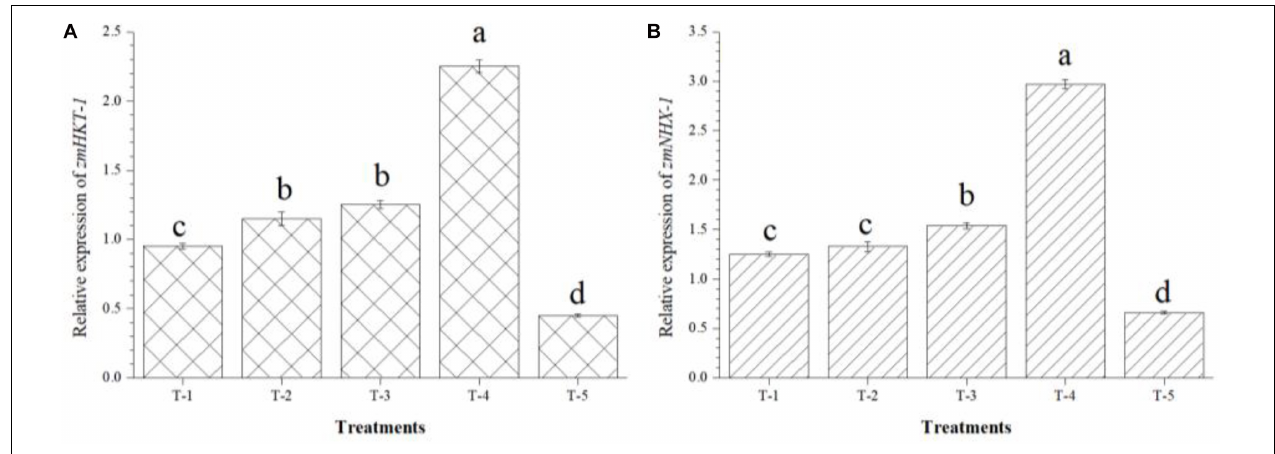
FIGURE 7 | Effects of seed bio-inoculation on expression profile of (A) zmHKT-1 and (B) zmNHX1 genes (fold change) in the maize roots grown in saline sodic soil at 45 days of sowing. Treatments were as follows: T 1 — B. safensis MF-01, T 2 — B. altitudinis MF-15, T 3 — B. velezensis MF-08, T 4 — B. safensis MF-01 + B. velezensis MF-08 + B. altitudinis MF-15, and T 5 —control (untreated). Data are mean ( n = 5) and vertical bar represents standard deviation. Data with different letters show significant difference in column data in randomized block design test at p < 0 . 05 under Duncan’s multiple range